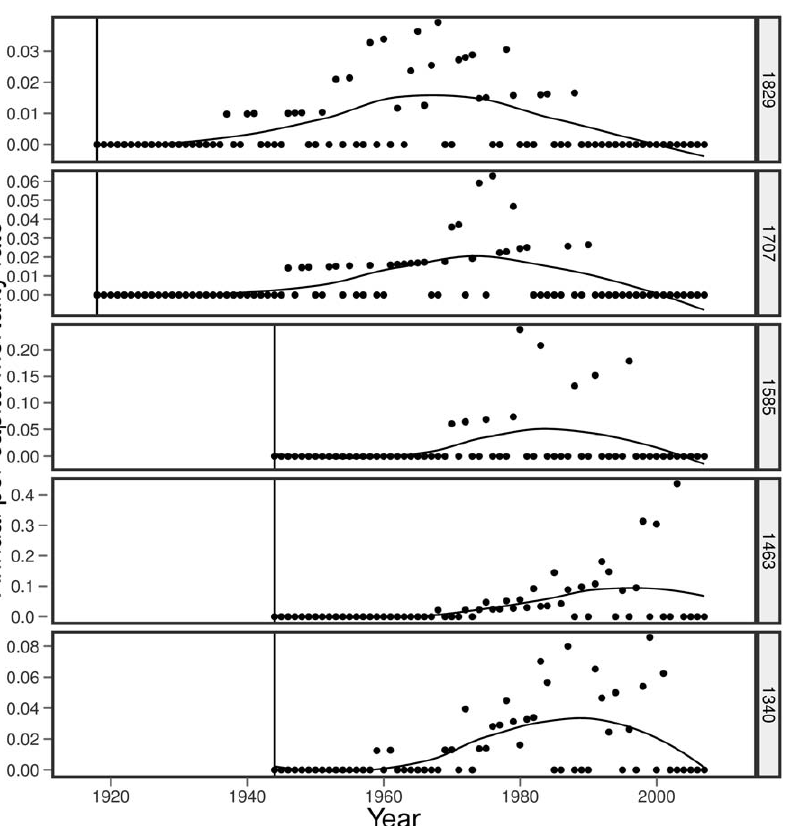
Figure 3. C.greggii per-capita mortality rates over time at five elevations. Vertical lines indicate year of stand establishment estimated from live stem ages. Fitted curves are loess curves [33] for overall illustration and estimation of year of peak mortality. The models that we considered are described in Table 2 and we used logit-transformed mortality rates. Stand age at peak mortality were estimated by loess smoothing (span=0.75) from low to high elevation were: 45,50,40,56, and 48.